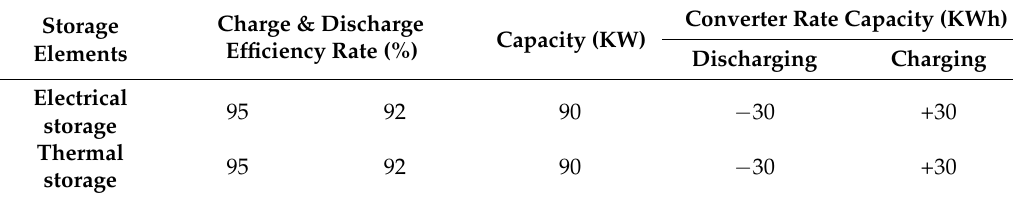
Table 2. Properties of the energy storage